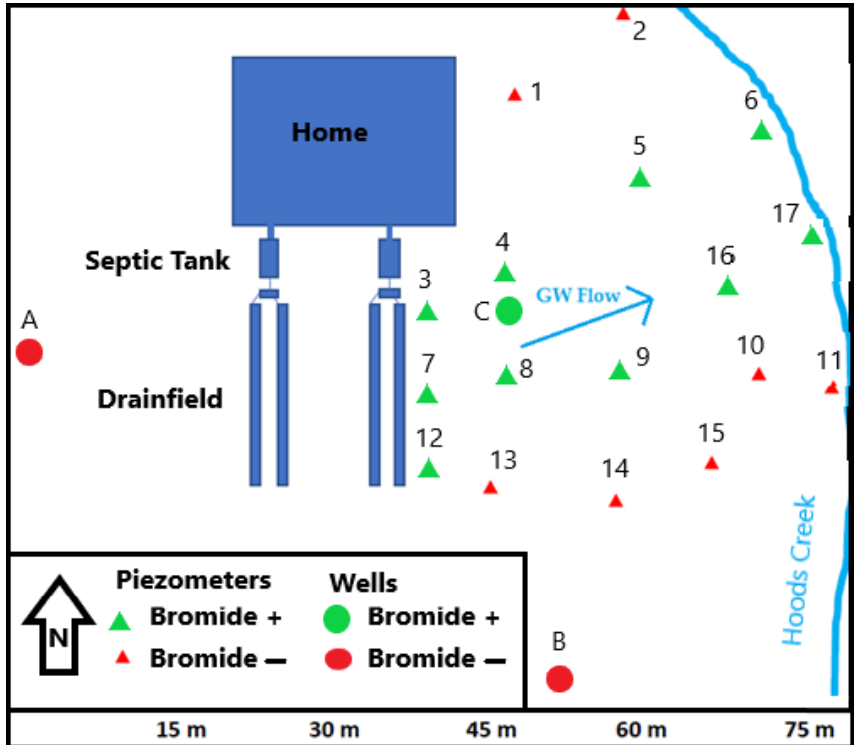
Figure 2. Groundwater monitoring infrastructure at Site 1, including wells and nests of piezometers between the drainfield and creek. Bromide tracer was in the groundwater at piezometer nests including 3 – 9, 12, 16, 17, and well C.